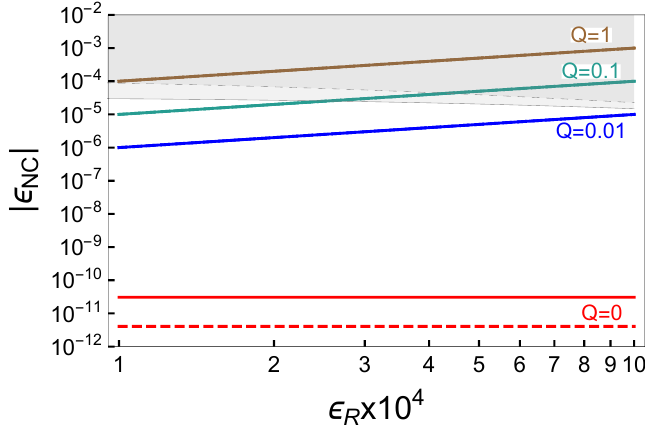
Figure 1 . The coupling (cid:15) NC as a function of (cid:15) R . Red, blue, green and brown lines correspond to Q = 0 , 0 . 01 , 0 . 1 and 1 , respectively. Solid and dashed ones correspond to (cid:15) = 5 × 10 − 4 and 10 − 4 . Gray filled region are exclusion region by the TEXONO